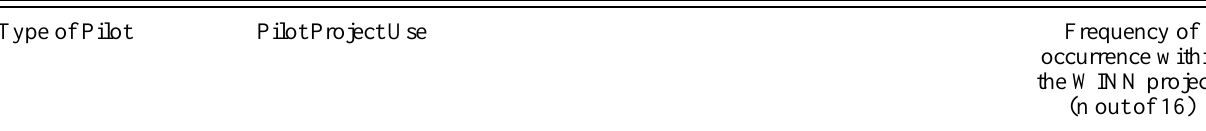
Table 2 . Pilot project uses and their frequency of occurrence within the analyzed WINN pilots Type of